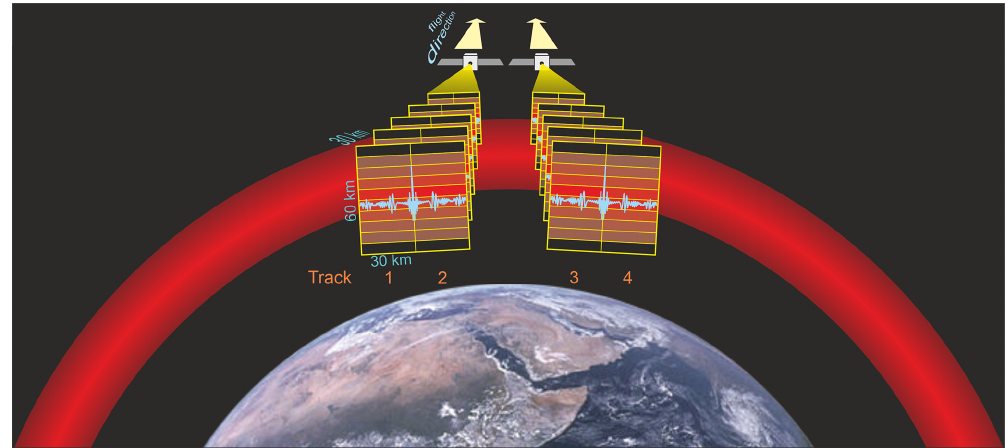
Figure 1. Proposed observation geometry of two CubeSats flying in parallel and viewing backward. Each CubeSat carries an SHI which images the atmosphere in the vertical and generates a combined spectral–spatial view in the horizontal. By splitting the interferogram at zero optical path difference, both sides can be evaluated individually, allowing for four effective observation